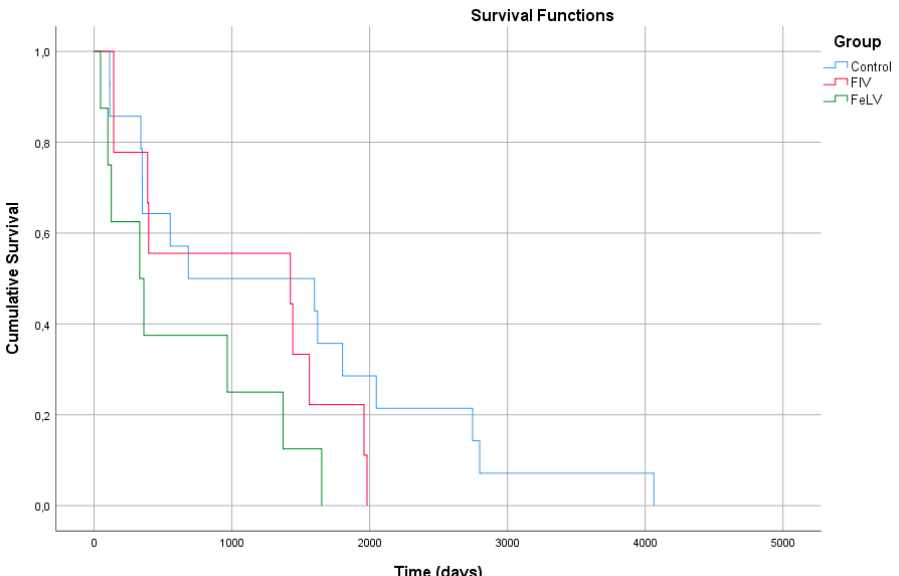
Figure 1. Kaplan-Meier curves from 16 cats of group control, 9 cats from group FIV and 8 cats from group FeLV.